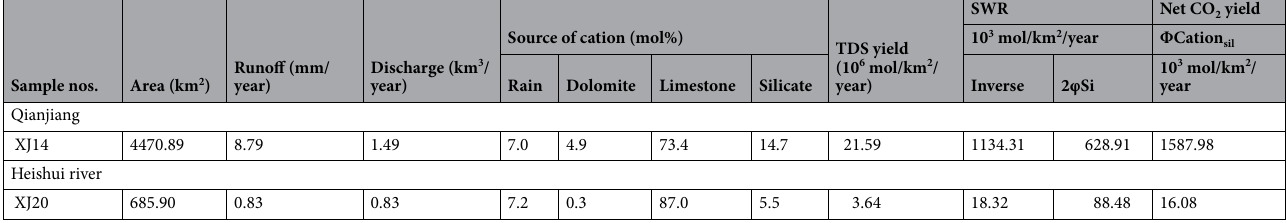
Table 9. Calculated dissolved fluxes for the Xijiang River.